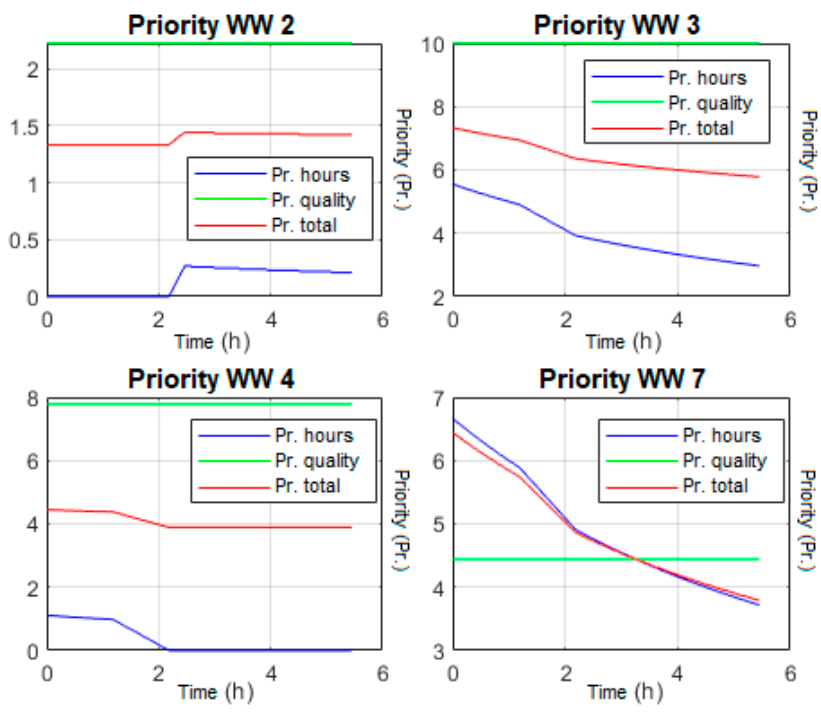
Figure 13. Water well priority indicators.